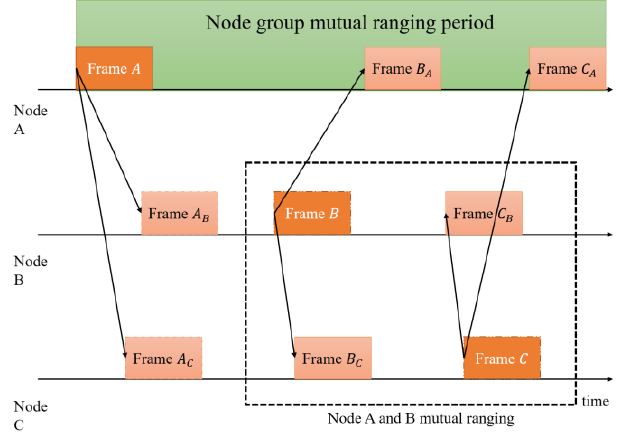
Figure 4. Multi-node broadcast mutual